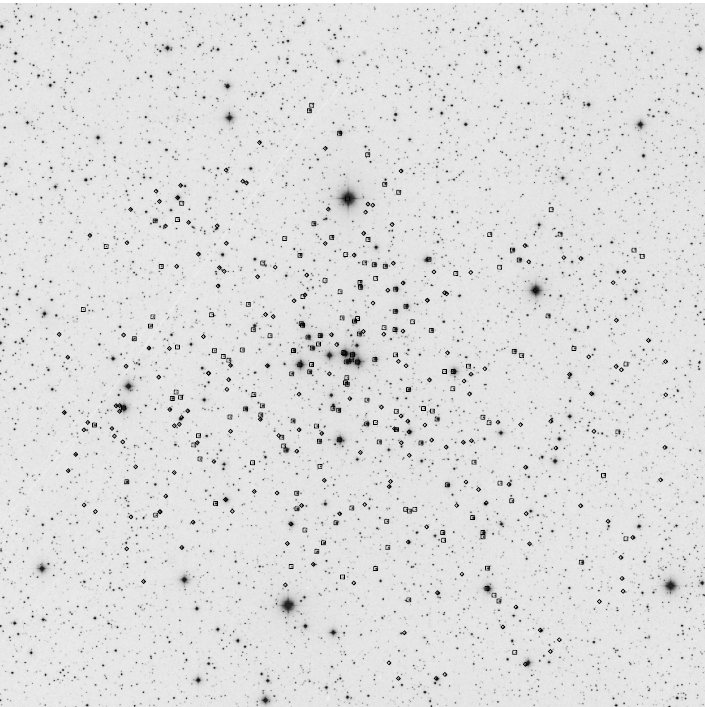
Figure 3. A 1 ◦ Digital Sky Survey field centered on NGC 2281 with north up and east to the left. Squares mark probable members and circles mark probable non-members that fit the selection criteria described in the text. Note that this field was not entirely covered by our